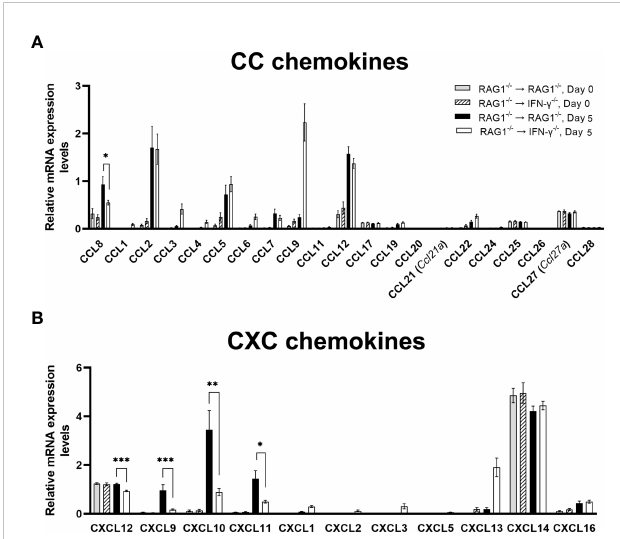
FIGURE 2 Cerebral mRNA levels for the molecules that recruit microglia, monocytes, macrophages, and T cells are upregulated by IFN- g production by brain- resident cells during reactivation of cerebral T. gondii infection. For the details of experimental methods, see the legend of Figure 1. The mRNA levels for (A) 21 CC chemokines and (B) 11 CXC chemokines were measured at both Day 0 and Day 5 in the brains of both groups of mice were measured using NanoString nCounter Mouse Myeloid Innate Immunity Panel. * P <0.05, ** P <0.01, and *** P <0.001. The data were combined from two independent experiments (n=5 for Day 0 and n=7 for Day 5 in both RAG1 -/- → RAG1 -/- and RAG1 -/- → IFN- g -/-